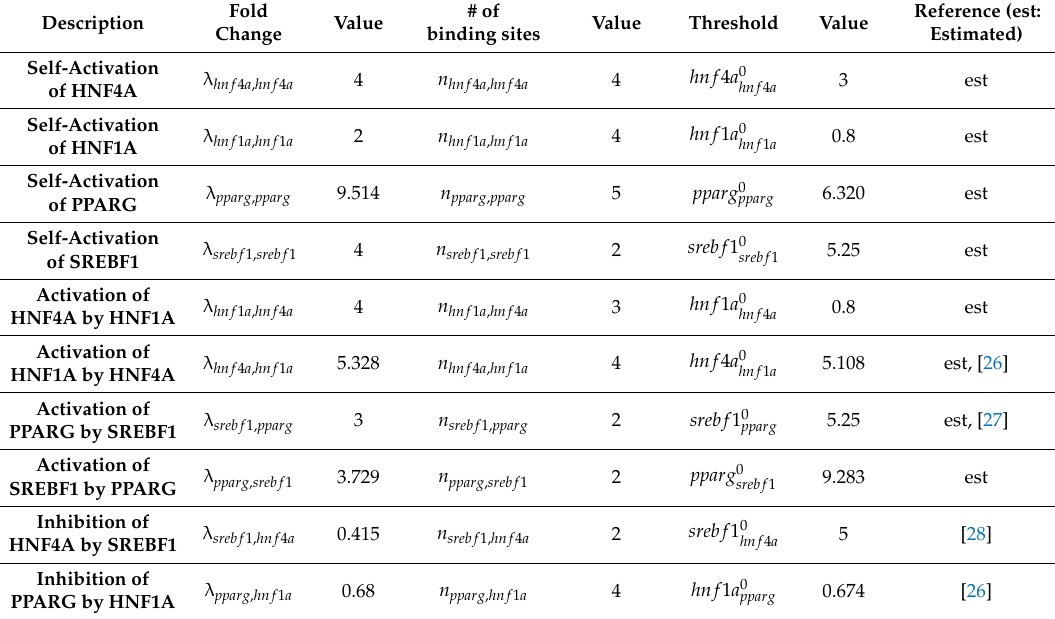
Table 2. Activation or inhibition parameters for the interaction.